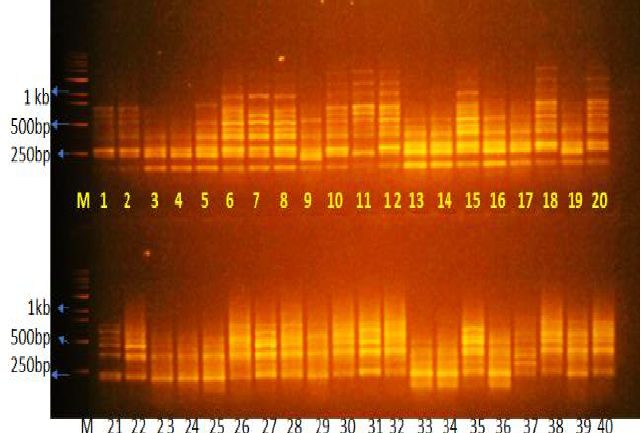
Figure 2. RAPD profiles of 40 finger millet landraces